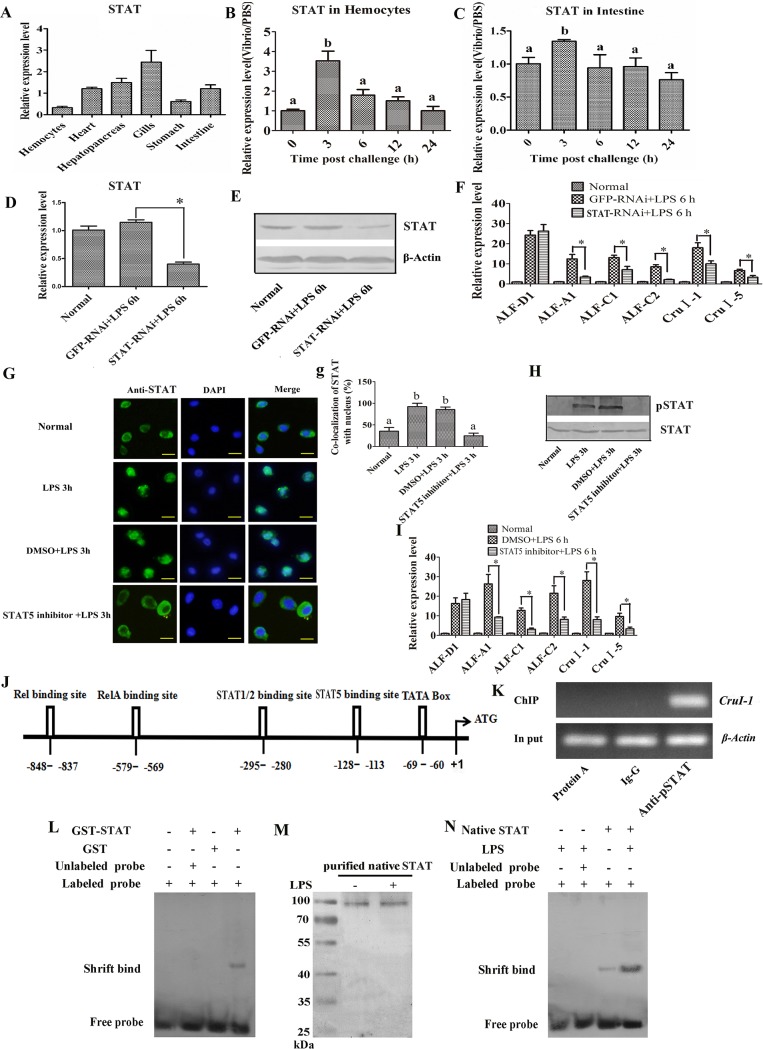
JAK/STAT pathway regulates expression of the same AMPs modulated by MjCC-CL.(A) The tissue distribution of STAT was analyzed with qRT-PCR. (B-C) The expression patterns of STAT in hemocytes (B) and intestine (C) were analyzed by qRT-PCR. (D) RNAi efficiency after dsSTAT injection was determined using qRT-PCR. (E) RNAi efficiency after dsSTAT injection was determined by western blotting. (F) The expression of ALF-A1, ALF-C1, ALF-C2, ALF-D1, CruI-1 and CruI-5 in STAT-RNAi shrimp challenged with LPS was determined by qRT-PCR. GFP-RNAi was used as a control. (G, g) STAT translocation into the nucleus in hemocytes was inhibited by the injection of a STAT5 inhibitor. (g) Statistical analysis of G: the localization of STAT in the nucleus of hemocytes was analyzed with WCIF ImageJ software. (H) STAT phosphorylation in the intestine was determined by western blotting after injection with a STAT5 inhibitor. (I) The expression of ALF-A1, ALF-C1, ALF-C2, ALF-D1, CruI-1 and CruI-5 in the intestine of shrimp injected with a STAT5 inhibitor was analyzed by qRT-PCR. (J) Genome walking was used to obtain the genomic sequence of CruΙ-1. The CruΙ-1 genomic sequence contains NF-κB (Rel/RelA) and STAT family protein binding sites, a TATA box and a transcriptional start site. (K) ChIP and RT-PCR were used to detect STAT binding to the CruΙ-1 promoter sequence. (L) EMSA detected a normal shifted band corresponding to STAT bound to the Dig-labeled CruΙ-1 probe. GST protein was used as a control. An unlabeled sequence of the CruΙ-1 probe was used as a competitor. (M) Native STAT was purified from intestine of untreated or LPS challenged kuruma shrimp using CNBr-activated Sepharose 4B by coupling the STAT antibody. (N) EMSA using native STAT protein purified from the intestine of shrimp challenged with LPS using CNBr-activated Sepharose 4B resin. Differences among the groups were analyzed using a t-test (p < 0.05) or with one-way ANOVA analysis; asterisks indicate significant differences (*p < 0.05, **p < 0.01).